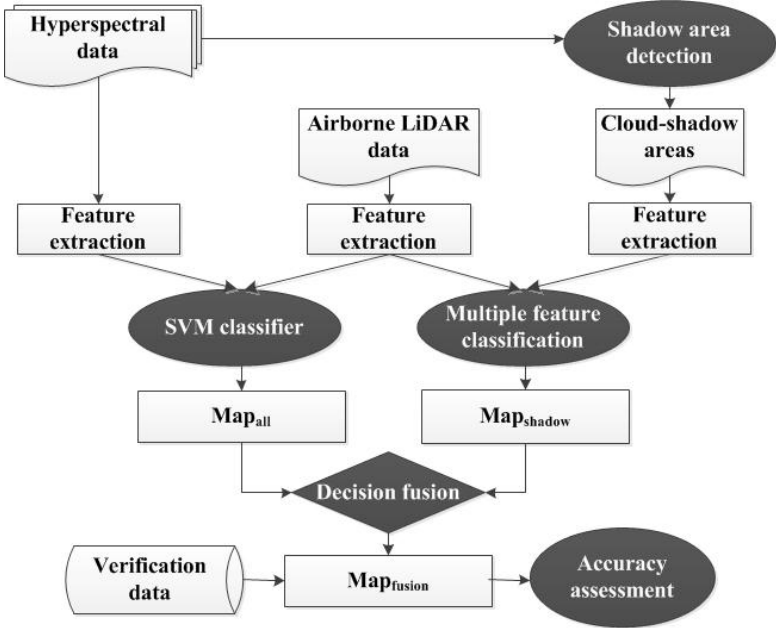
Figure 2. Flowchart of the proposed method.